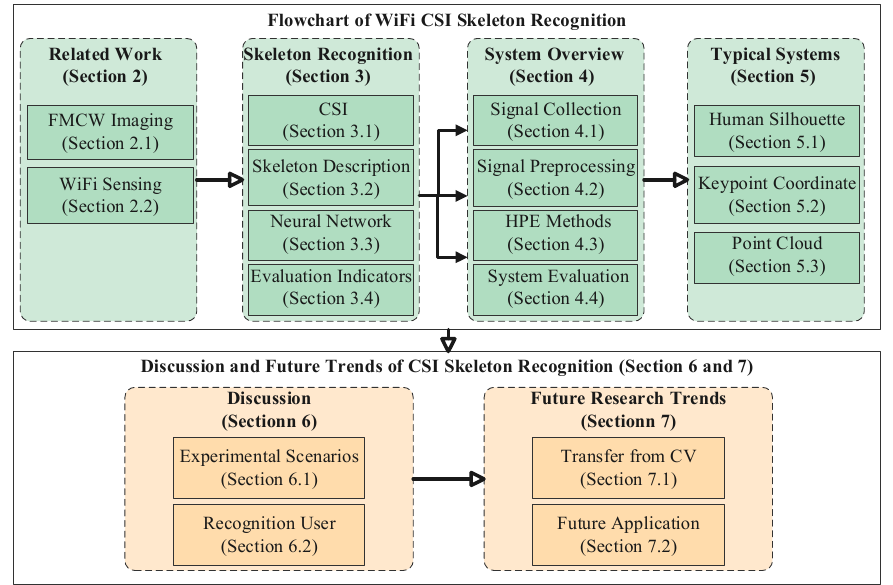
Figure 1. Taxonomy of this